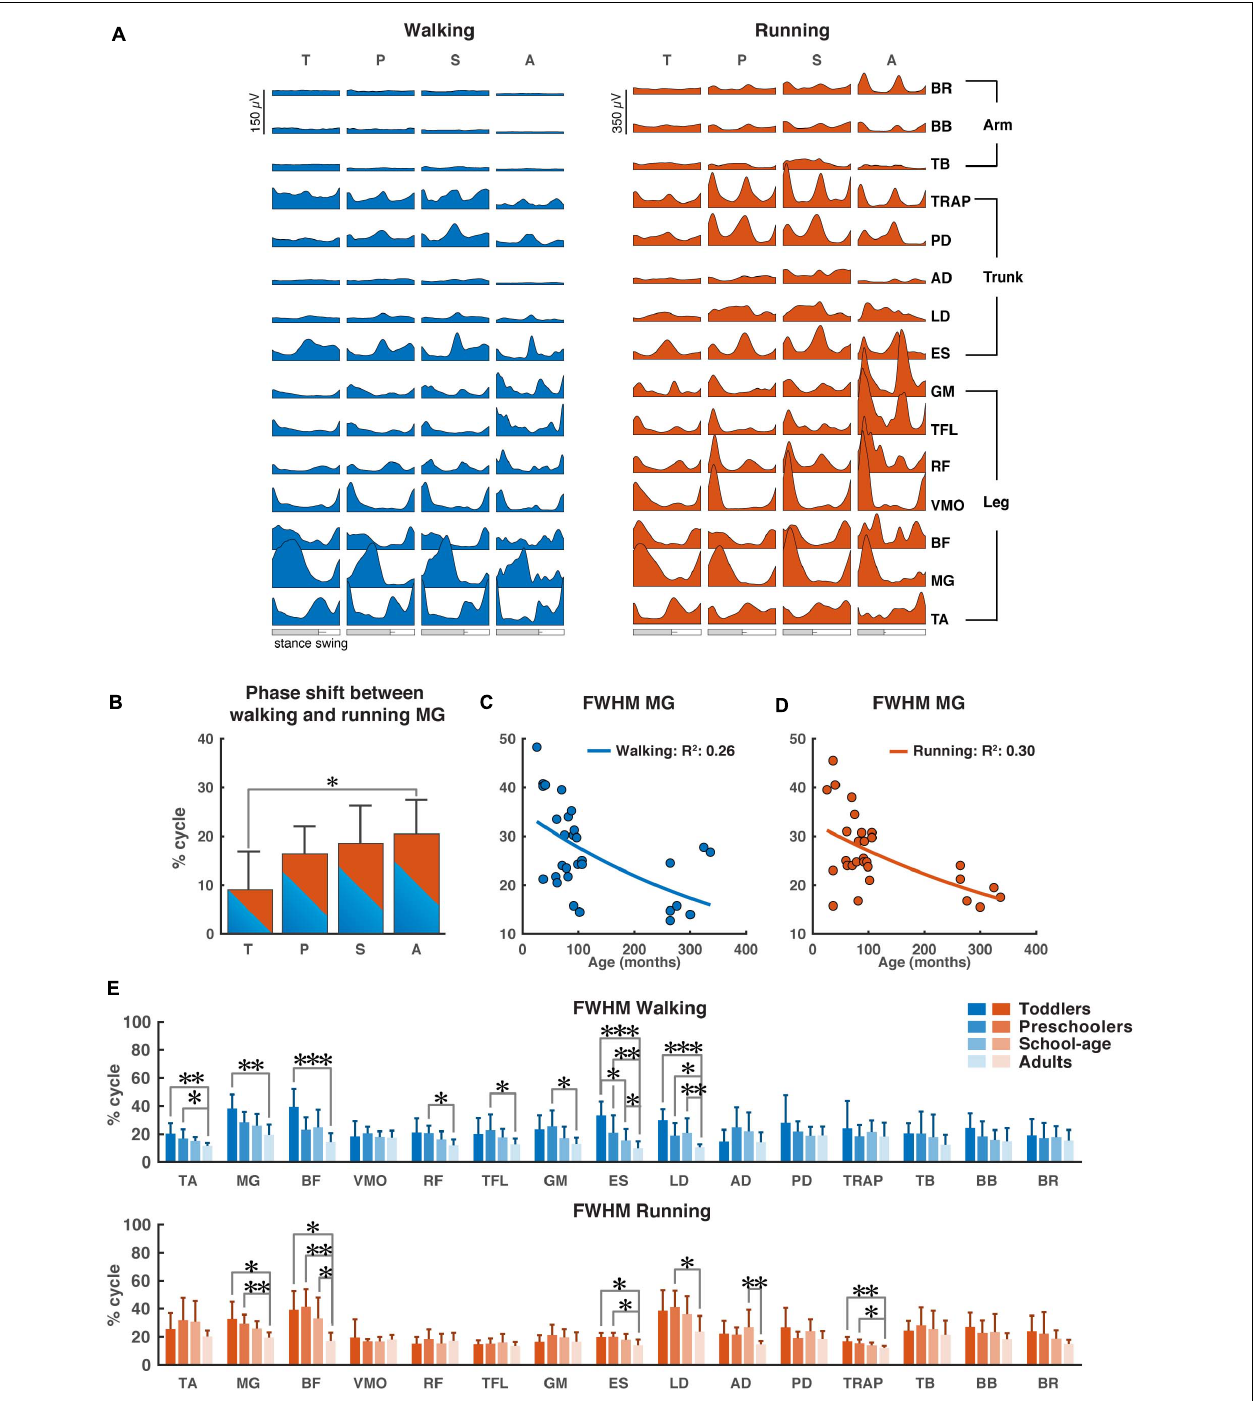
FIGURE 2 | Characteristics of EMG signals. (A) Grand averages of 15 EMG activity patterns for walking (blue) and running (red) for all four groups, data are plotted vs. normalized gait cycle, relative duration of stance varied across groups, a bar indicates an amount of variability in the stance phase duration across groups. (B) Phase shift between the peak activation of medial gastrocnemius (MG) for walking and running for each group, positive value indicates a lag of walking signal relative to running signal. (C,D) Full-width half-maximum (FWHM) of the MG activity as a function of age for walking (C) and running (D) . Continuous lines represent exponential fittings, note the decrease in values with age. (E) FWHM of all muscles (means + SD) for the four groups. TA, tibialis anterior; MG, medial gastrocnemius; BF, biceps femoris; VMO, vastus medialis oblique; RF, rectus femoris; TFL, tensor fascia latae; GM, gluteus maximus; ES, erector spinae; LD, latissimus dorsi; AD, anterior deltoid; PD, posterior deltoid; TRAP, trapezius; TB, triceps brachii; BB, biceps brachii; BR, brachioradialis; T, toddlers; P, preschoolers; S, school-age; A, adults; FWHM, full-width half-maximum. * p < 0.01, ** p < 0.001, and *** p < 0.0001.